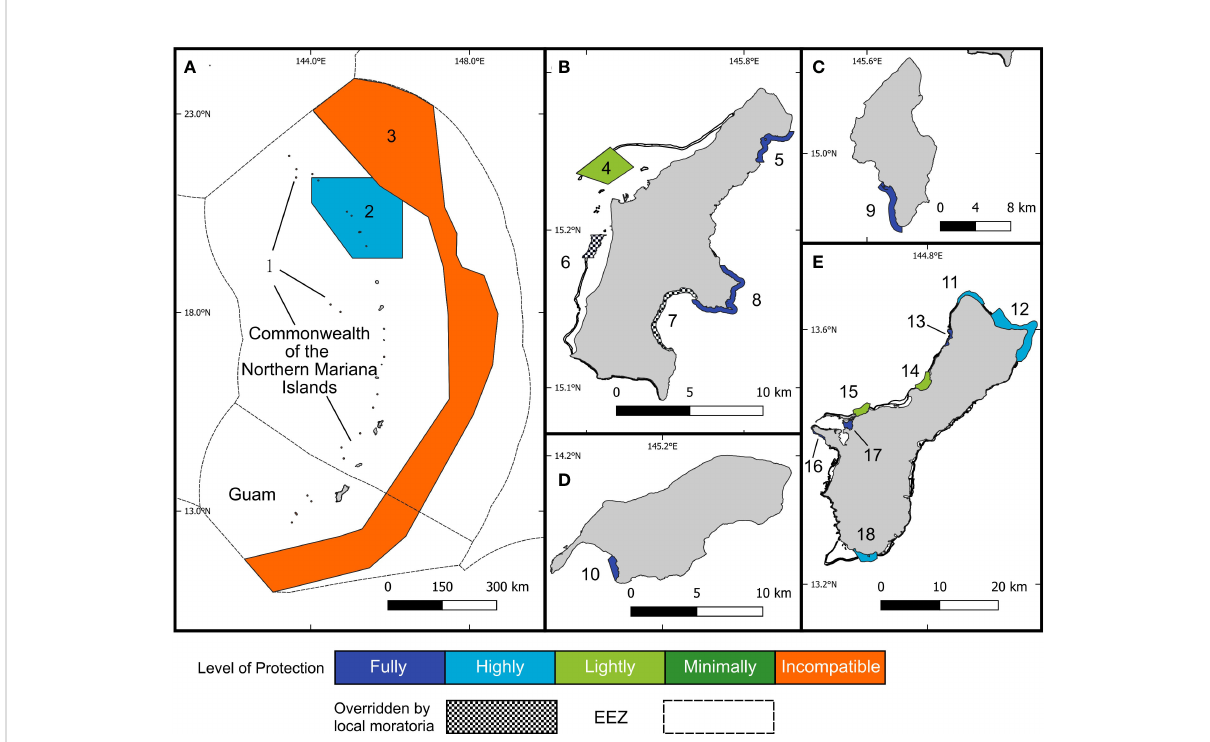
FIGURE 1 Map of spatial marine conservation in the Mariana Islands. (A) The Mariana Trench Marine National Monument and National Wildlife Refuge units extend across both territorial exclusive economic zones (EEZ). (B-E) Maps of spatial marine conservation areas on Saipan, Tinian, Rota, and Guam, respectively. Numbers refer to site names found in Table